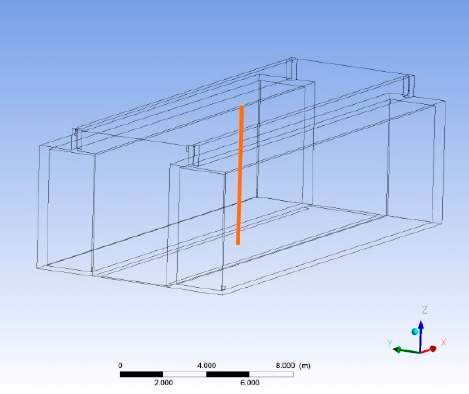
Figure 9. Vertical profiles located in the centre of the alley facing the prevailing wind route.